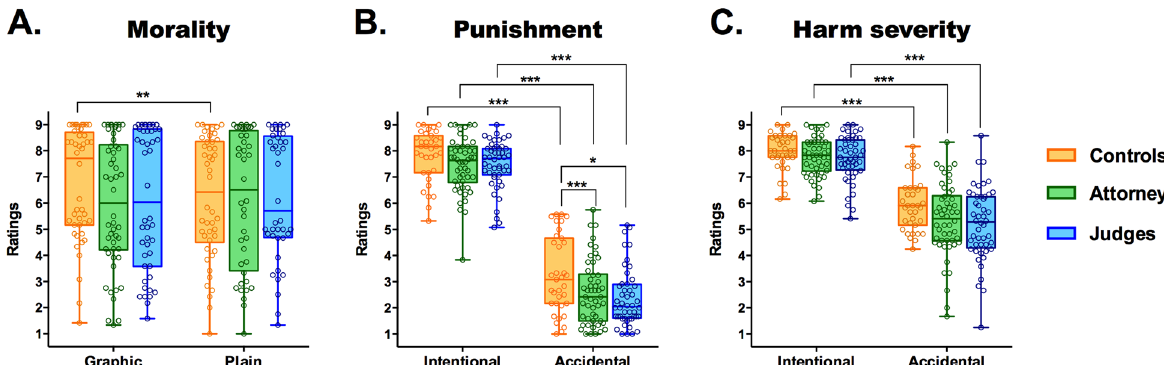
Fig. 2 Effects of gruesome language (GL) and intentionality on morality, punishment and damage ratings. a We observed a group-by-language interaction, such that only participants of the control group had signi fi cantly higher morality ratings when reading gruesome descriptions of harm, relative to the PL condition. b We also found a group-by-intentionality interaction, revealing that punishment ratings were signi fi cantly lower for the judges and attorneys groups in comparison to controls during accidental scenarios. There were no differences between groups when participants read intentional scenarios. c We found a group-by-intentionality interaction, revealing that harm severity ratings were signi fi cantly lower for judges and attorneys than controls in accidental scenarios. Participants in all groups assessed harms as signi fi cantly greater in magnitude when they were committed intentionally, in comparison to situations when harm was accidentally caused. This reveals a biasing effect of intentionality on damage assessments, because the accidental and intentional conditions contained an equivalent range of harms. Signi fi cance coding: * p < 0.01; ** p < 0.001; *** p <